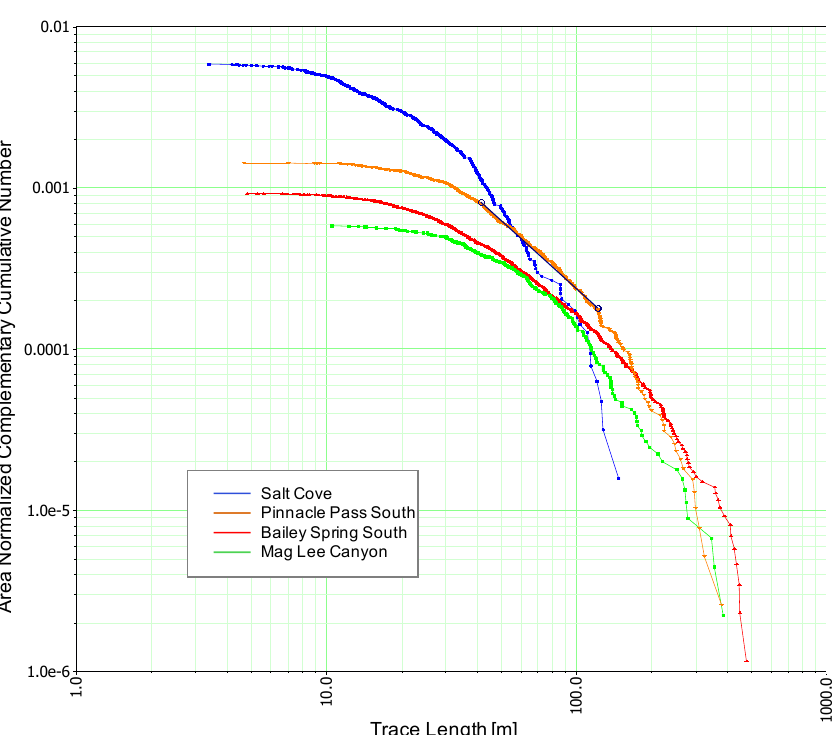
Figure 7. Power law fit to outcrop trace length data. The slopes of the straight-line segments on this log-log plot of the area normalized complementary cumulative number vs the trace lengths range from − 1.3 to −